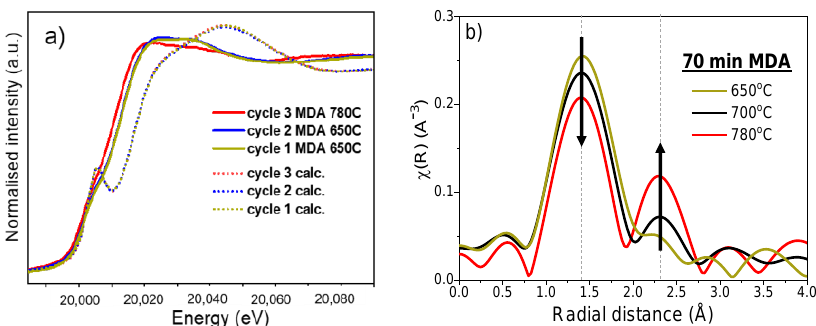
Figure 4. ( a ) Mo K-edge XANES obtained of Mo / H-SSZ-13 during the consecutive calcination and MDA cycles, and ( b ) Mo K-edge FT-EXAFS of Mo / H-SSZ-13 after 70 min of MDA reaction at 650 (cycle 1), 700, and 780 ◦ C (cycle